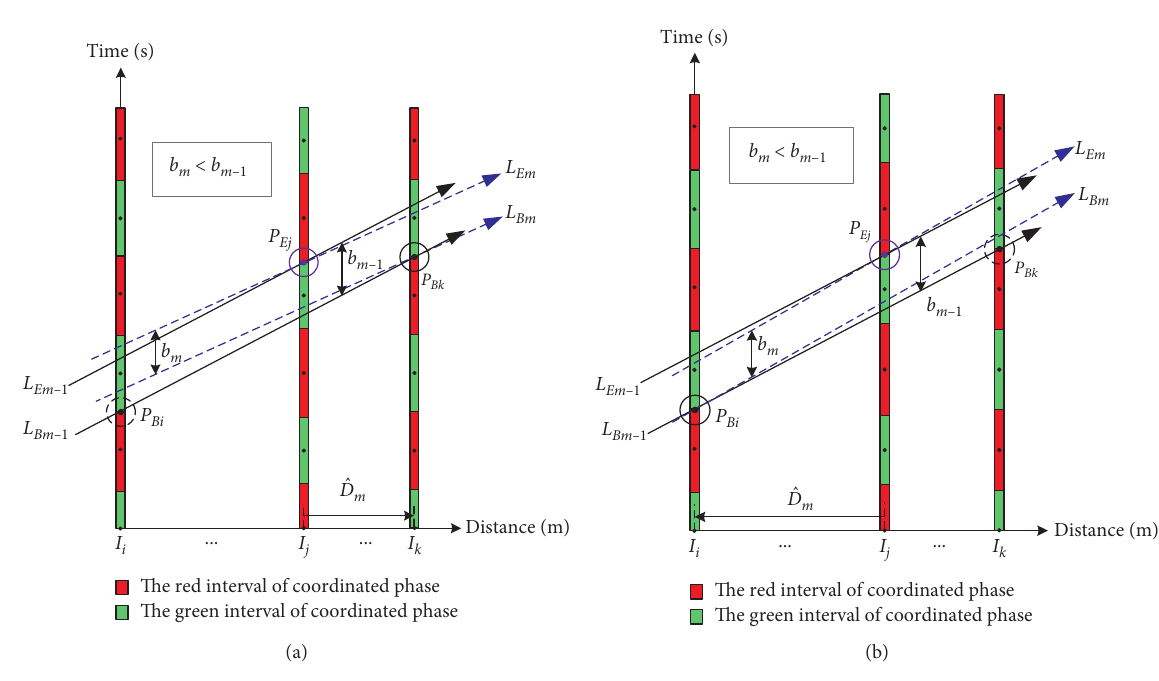
Figure 7: Condition 3 for stopping the rotation. (a) V